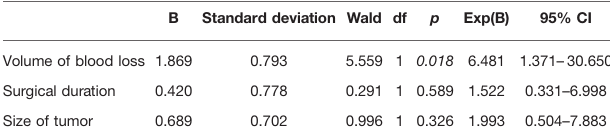
TABLE 3 | The results of multivariate